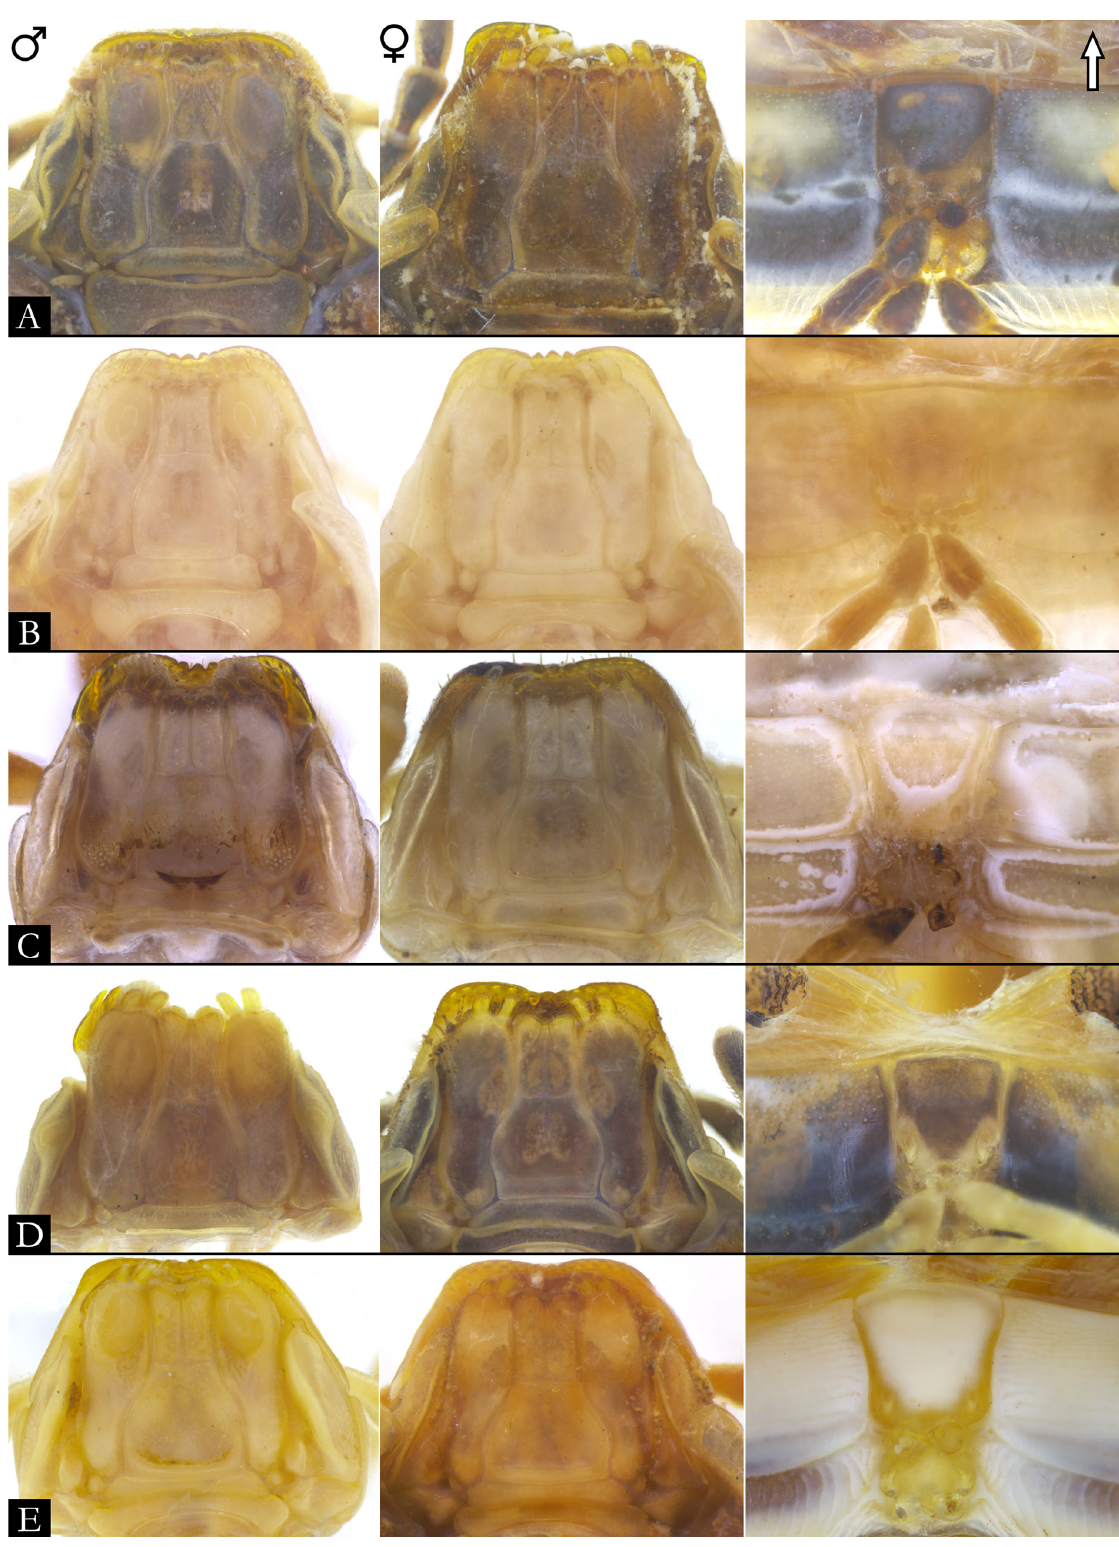
Fig. 171. Stereoscopic images of gnathochilarium and anterior sternum of species of